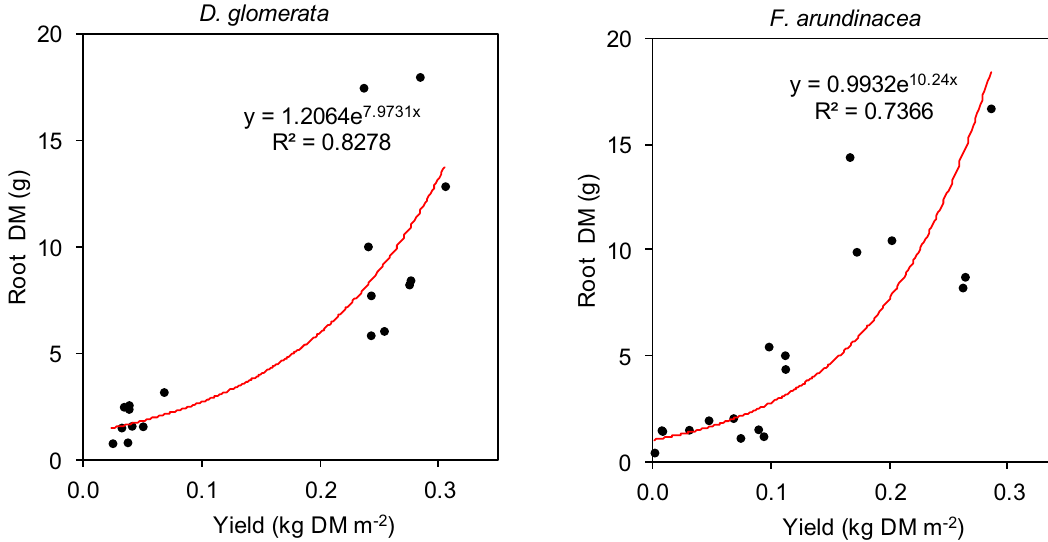
Figure 6. Relationship between root dry matter and annual aboveground biomass productivity of tall fescue and cocksfoot. Solid line is the fitted non-linear